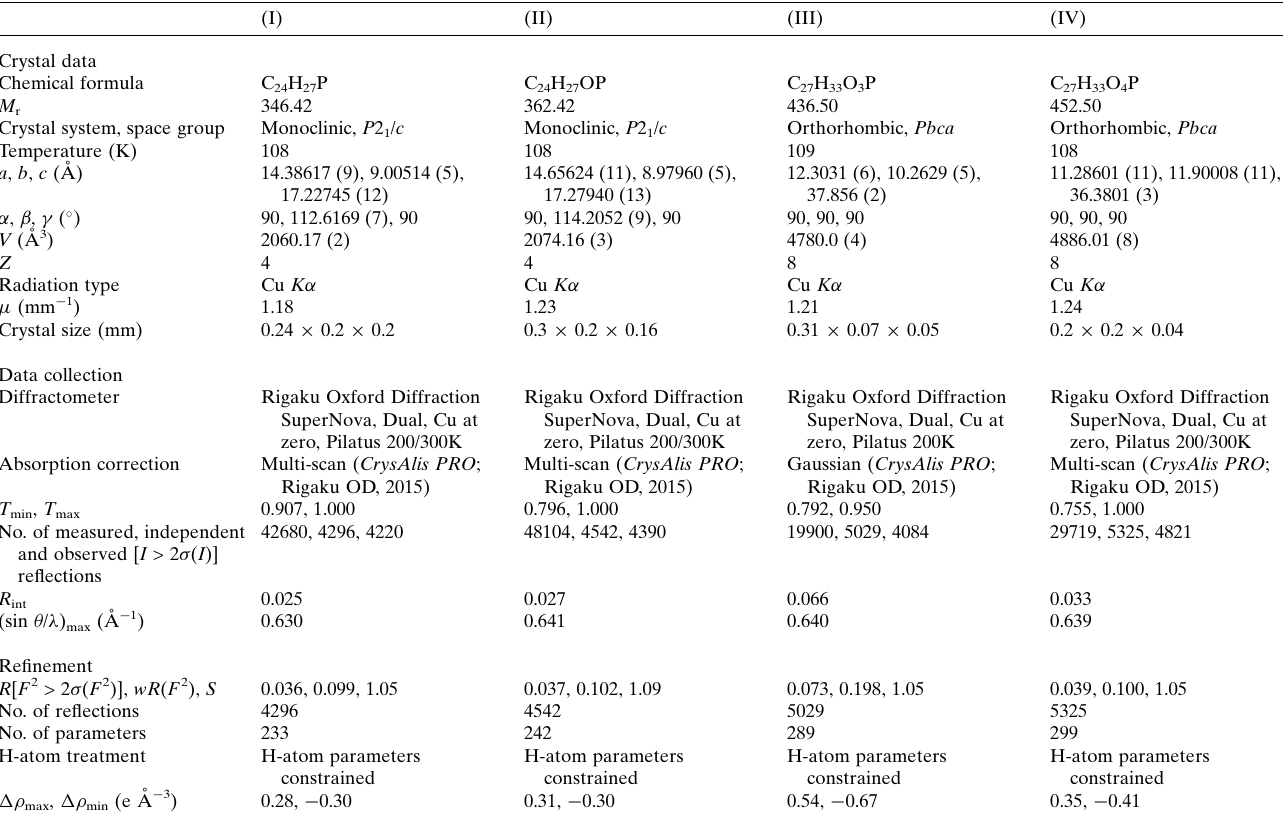
Table 4 Experimental details.